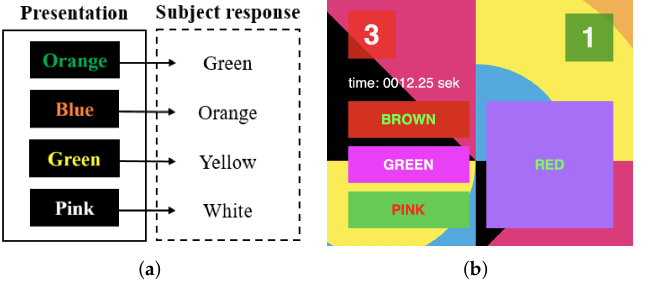
Figure 4. Stroop test ( a ) a psychological test definition; ( b ) screenshot from the VR application (3rd